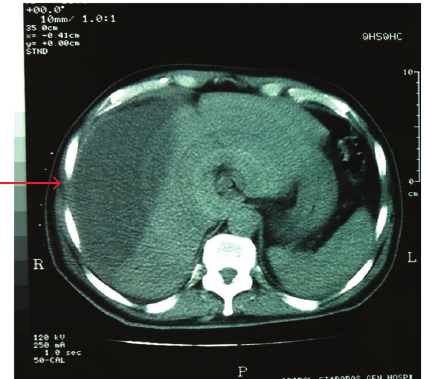
Figure 1: Ultrasound examination of the abdomen showing a hypoechoic subcapsular collection of the liver (arrow).